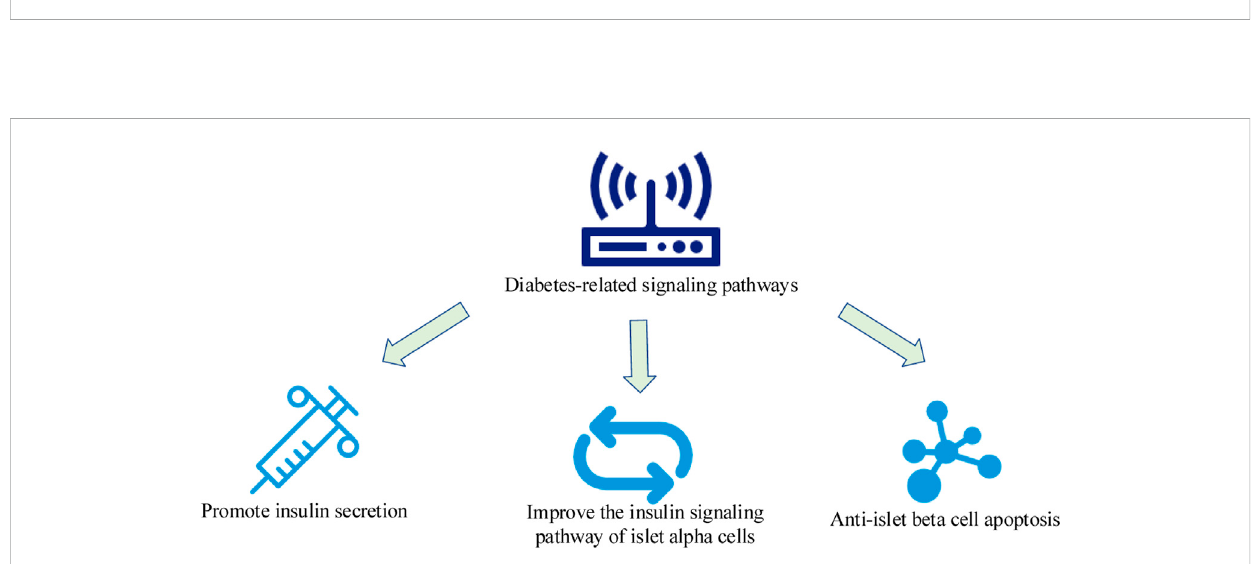
FIGURE 3 Pancreatic tissue as a target for the treatment of diabetes-related signaling